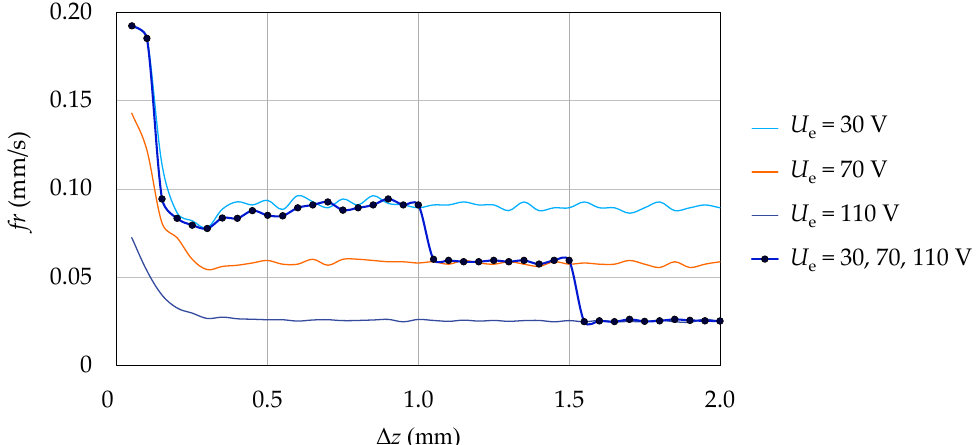
Figure 9. A comparison of the evolution of fr during four different drilling experiments. In three experiments the reference voltage ( U e ) is unvaried, while in the other experiment U e is varied at steps of 0.5 mm in depth after touch-in (first 0.5 mm in depth). The data points correspond to the in-line monitored values of fr during the latter experiment. The other parameters are unvaried during the four experiments. In particular, the levels of the factors are: A = +1, B = − 1, C = − 1.